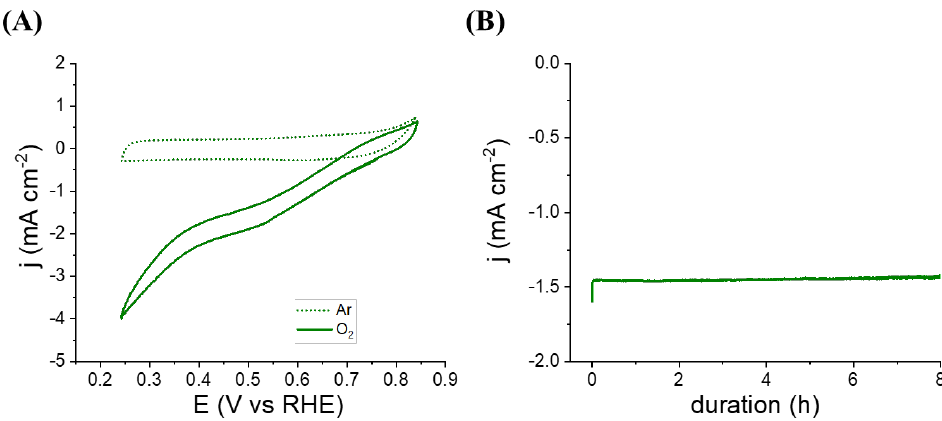
Figure 3. ( A ) Cyclic voltammograms recorded in phosphate buffer (pH 6.5; 1 mV s −1 ) at a hollow electrode based on hemin-L bp containing 0.5 mg of ABTS and 2.0 mg of BOx under argon (dashes) or O 2 (solid line). ( B ) Chronoamperometric measurement at 0.5 V under oxygen-purged phosphate buffer.